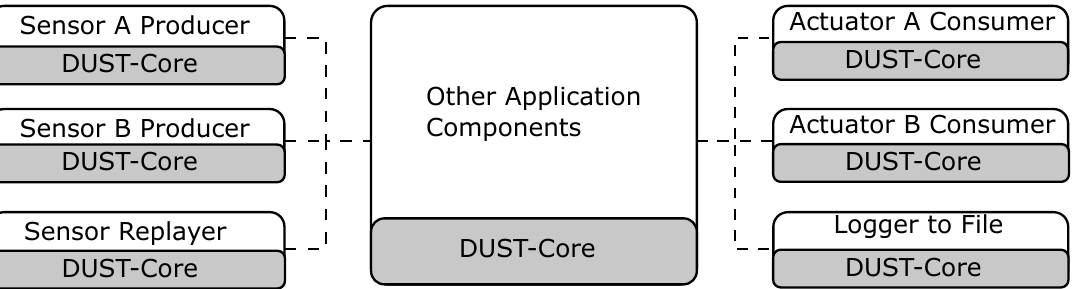
Figure 7. The hardware is transparent to the processing application components.